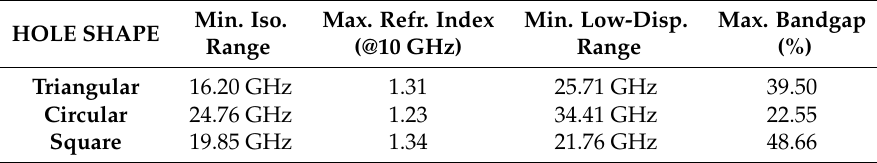
Table 2. Comparison among the optimal values of different metastructures possessing glide symmetry. The geometrical parameters of the unit cells are: h hole = 1.5mm, g = 0.2mm, and d x = d y = 4.5mm. The optimal values for the triangular hole are: Min. Iso. Range, Max. Refr. Index, Min. Low-Disp. Range and Max. Bandgap ( e = 0.99 d ). The optimal values for the circular hole are: Min. Iso. Range (2 r circle = 0.78 d ), Max. Refr. Index (2 r circle = 0.85 d ), Min. Low-Disp. Range (2 r circle = 0.85 d ), and Max. Bandgap (2 r circle = 0.78 d ). The optimal values for the square hole are: Min. Iso. Range ( l square = 0.71 d ), Max. Refr. Index ( l square = 0.76 d ), Min. Low-Disp. Range ( l square = 0.76 d ), and Max. Bandgap ( l square = 0.71 d ). Min. Iso. Max. Refr. Index Min. Low-Disp. Max. Bandgap HOLE SHAPE Range (@10 GHz) Range (%) Triangular 16.20 GHz Circular 24.76